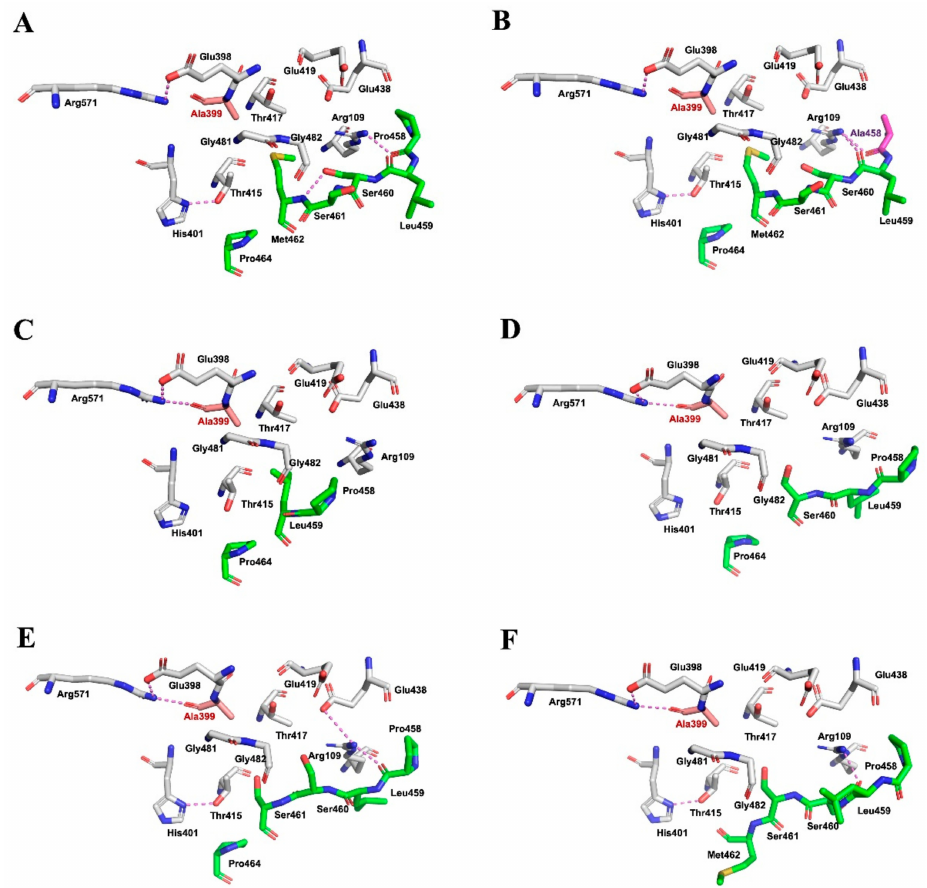
Figure 6. Comparison of the self-activating environments of wild-type and mutant enzymes. The self-activating environments were plotted by the program PyMOL (https: // pymol.org). Important residues, including Arg109, Glu398, Ala399, His401, Thr415, Thr417, Glu419, Glu438, Gly481, Gly482, and Arg571, are shown. The self-activating environments of wild-type and mutant enzymes were individually presented in panels ( A) ( Bl GGT), ( B ) (P458A), ( C) ( ∆ S460-M462), ( D) ( ∆ S461-M462), ( E ) ( ∆ M462), and ( F ) ( ∆